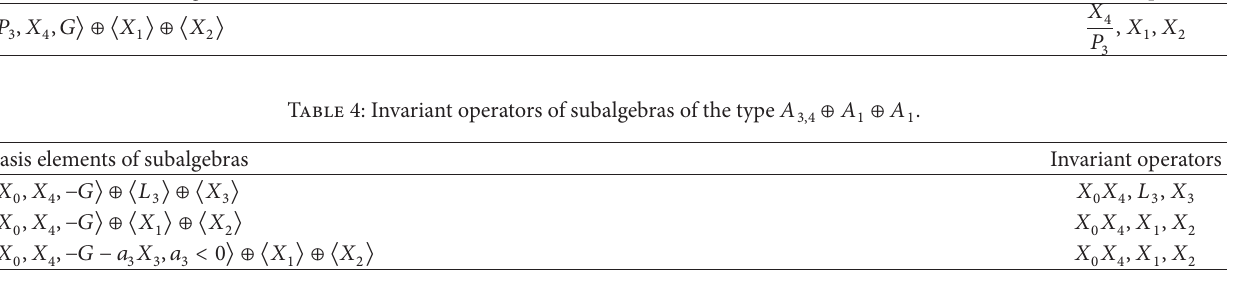
Table 3: Invariant operators of subalgebra of the type 𝐴 3,3 ⊕ 𝐴 1 ⊕ 𝐴 1 . Basis elements of subalgebras